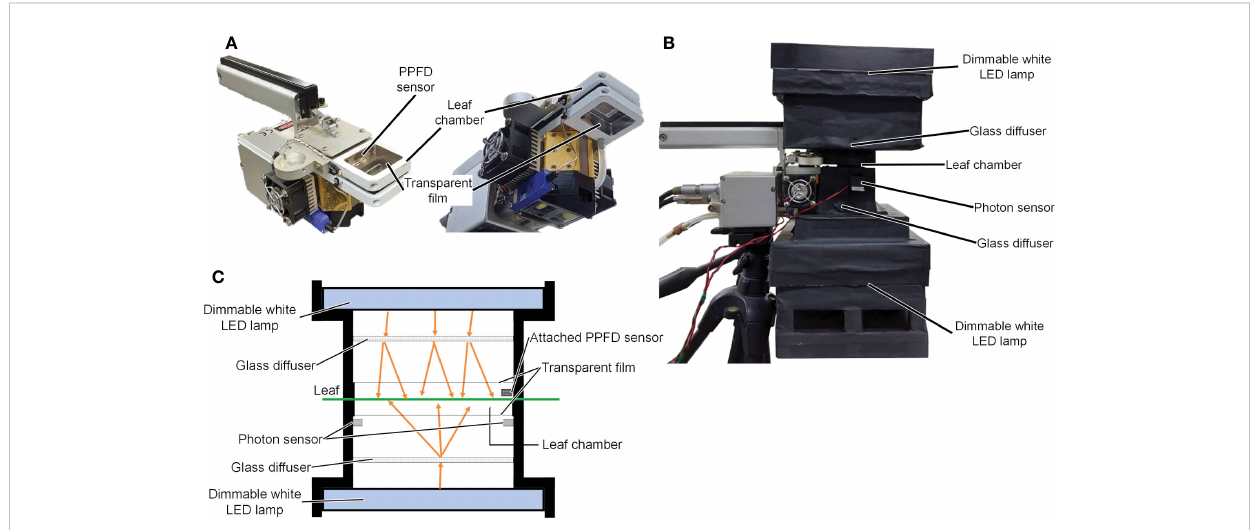
FIGURE 1 Images of LI-6400XT (LI-COR Inc.) with the transparent chamber (A) and the net photosynthetic rate measurement device (B) . Schematic diagram of the net photosynthetic rate measurement device (C)